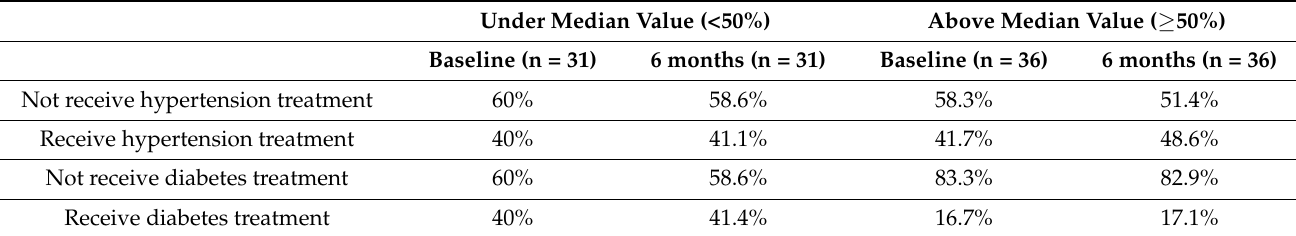
Table 2. Summaries of the characteristics of the population “Baseline” and “6 months” stratified by adherence to Mediterranean diet.